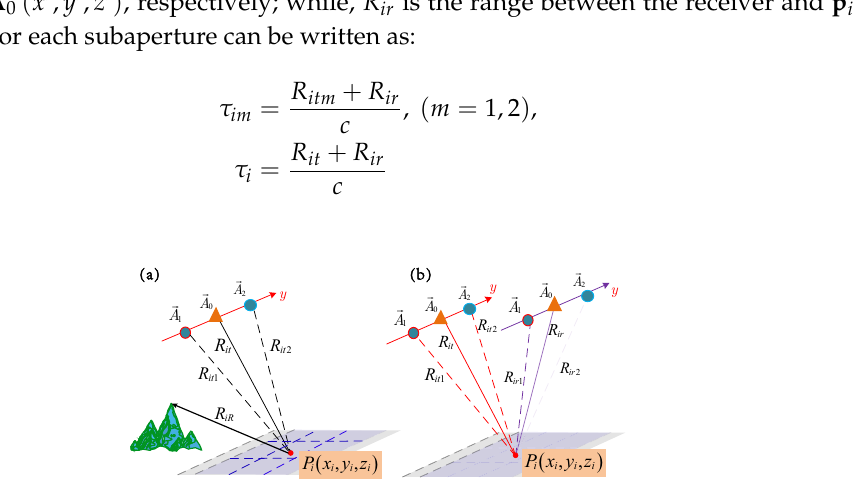
Figure 4. Bistatic SAR cases: ( a ) one-stationary bistatic mode; ( b ) azimuth-invariant bistatic